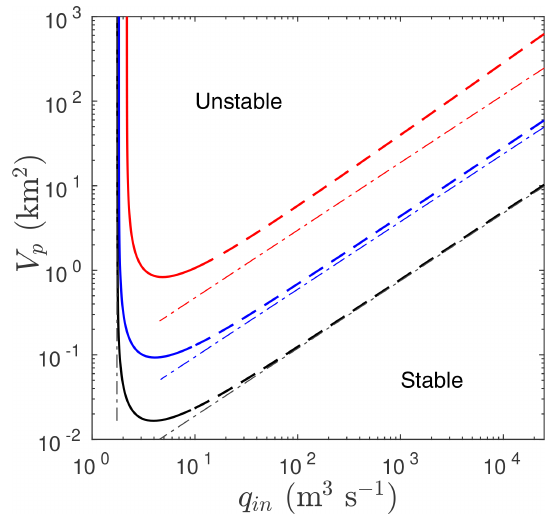
Figure 2. Stability boundaries for reservoir systems with the pa- rameter values in Table 1 shown as solid/dashed curves. Note the logarithmic scales on the axes. The unstable region in parameter space is above the curves as shown. The curves correspond to dif- ferent values of L : 10km (red), 50km (blue) and 250km (black); the latter is not intended to be physically realistic but to reflect the limit of large L . The Hopf bifurcation at the stability boundary is supercritical where the curve is solid and subcritical where dashed (see Sect. 3.3). The dotted–dashed curves show the asymptotic sta- bility boundaries given by Eqs. (12) and